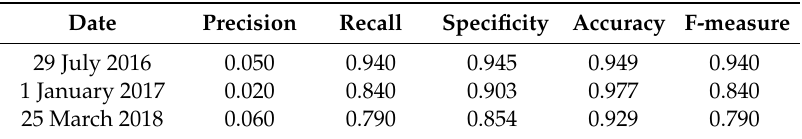
Table 10. Precision, recall, specificity, accuracy, and F-measure based on the confusion matrix for three image dates by the test dataset of 100 demolished and 100 remaining